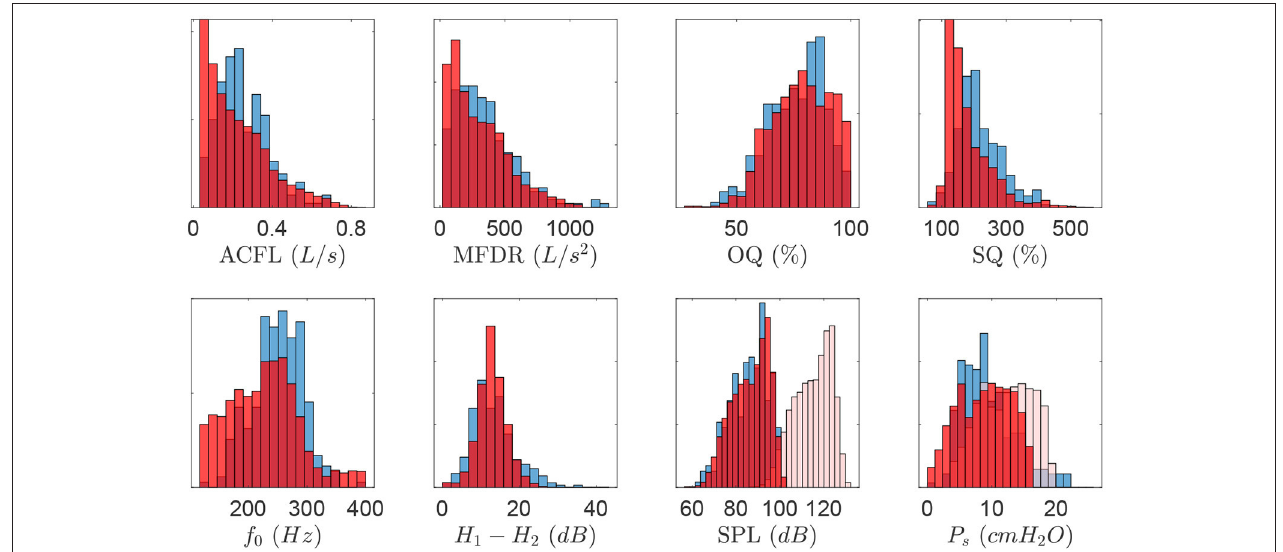
FIGURE 3 | Normalized histogram describing vocal features obtained for all measured quantities in the clinical data set (blue color). Resulting histograms for the synthetic dataset (red color) are superimposed to illustrate model matching. Bias correction for synthetic SPL and Ps are shown as additional histograms (light red